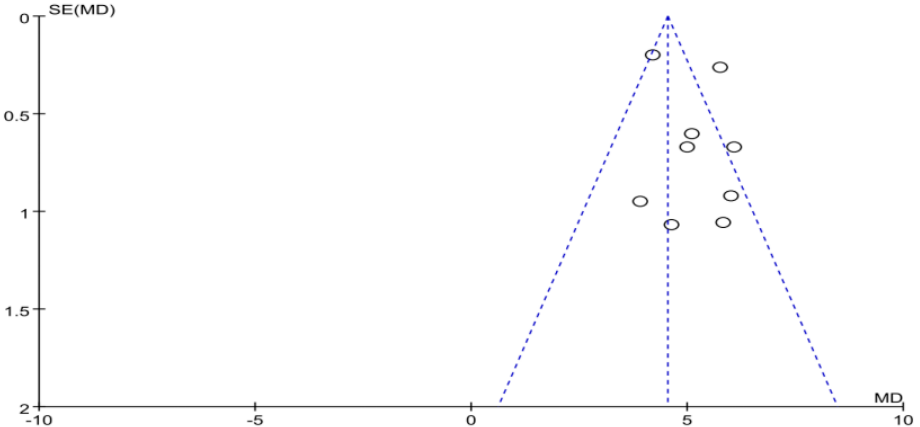
Figure 4. Funnel plot for publication bias of withdrawal symptoms.